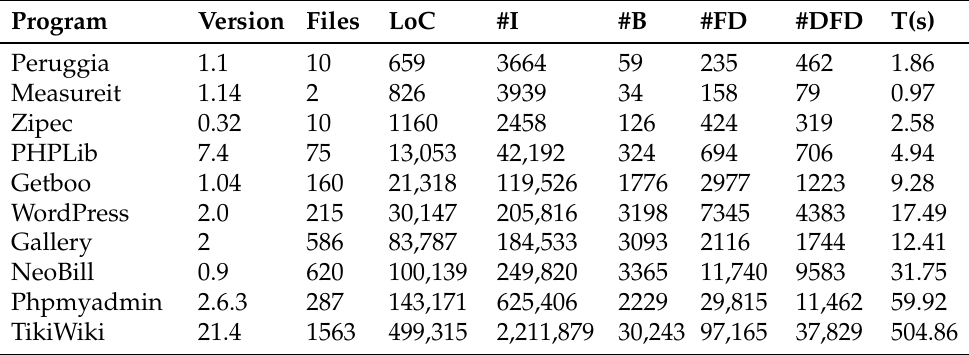
Table 6. Summary of running the proposed approach with open source applications.